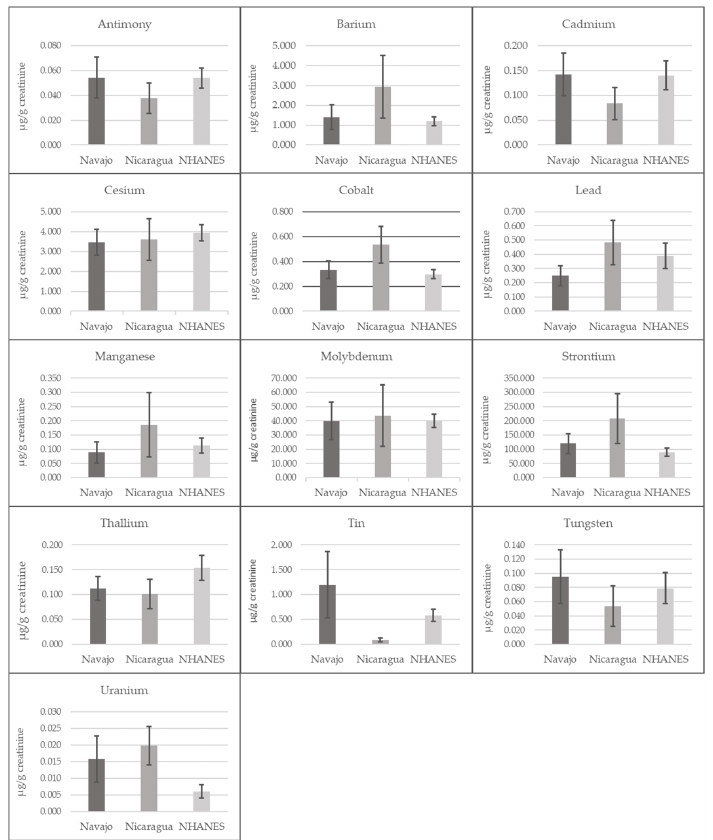
Figure 1. Distribution of geometric mean metal concentrations (µg/g creatinine) and 95% confidence limits in comparison with geometric mean concentrations of the United States adult male